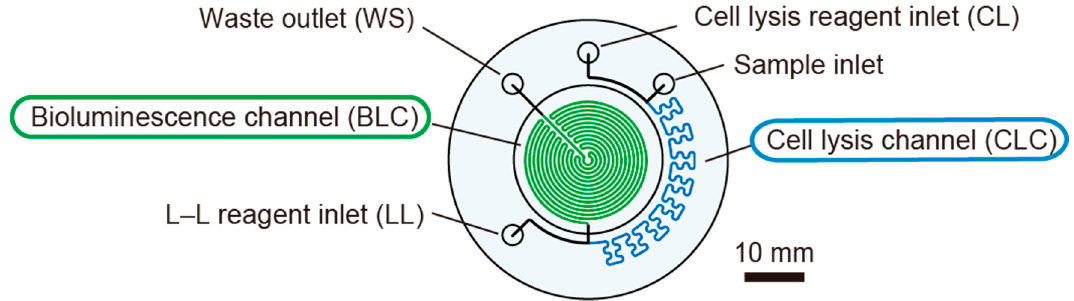
Figure 5. Microfluidic device for the in-situ ATP analyzer.